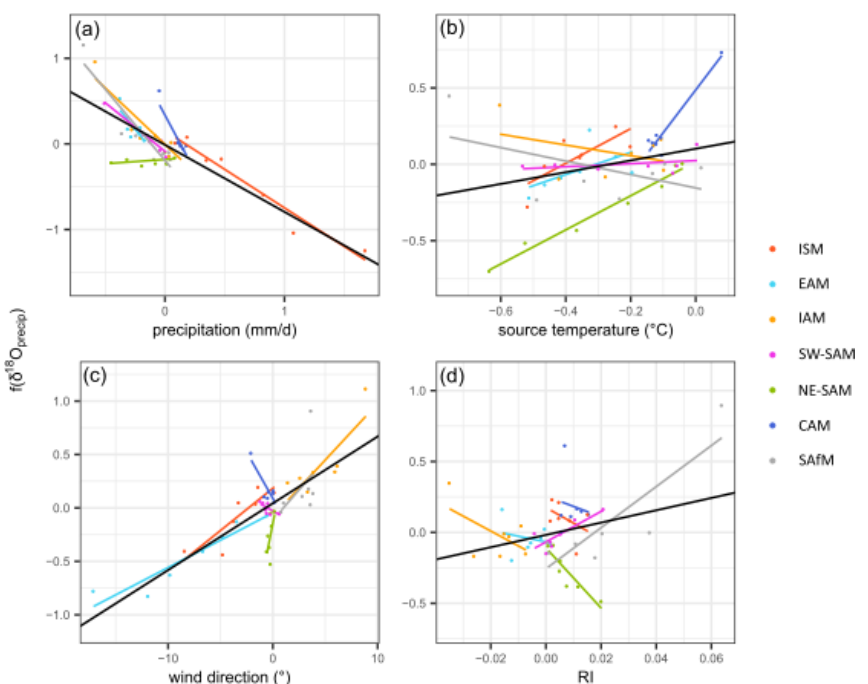
Figure 6. Partial residual plots from the multiple linear regression analysis, showing the relationship between anomalies in simulated δ 18 O precip and the four predictor variables, after considering the fitted partial effects of all the other predictors. The simulated δ 18 O precip values are anomalies relative to the pre-industrial control simulation and are annual values weighted by precipitation amount. The predictor variables are precipitation in the delineated monsoon region (mmd − 1 ), temperature in the source region ( ◦ C), surface wind direction over the source region ( ◦ ) as an index of potential changes in source region and the ratio of precipitation recycling to total precipitation over the monsoon region (RI, unitless). The predictor variables are summer mean values, representing the summer monsoon, where summer is defined as May to September for the Northern Hemisphere monsoons and November to March for the Southern Hemisphere monsoons.